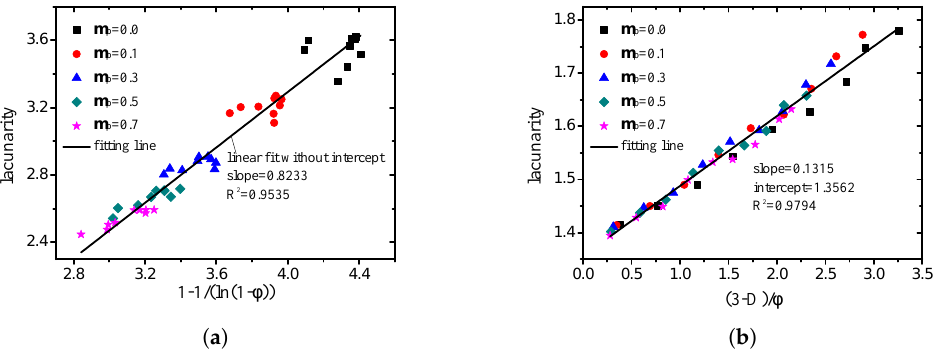
Figure 15. Comparison of lacunarity measured from DEM simulation with values calculated by two empirical relationships provided in this study (( a ) box size = 2 ( < minimum particle size); ( b ) box size = 16 ( > minimum particle